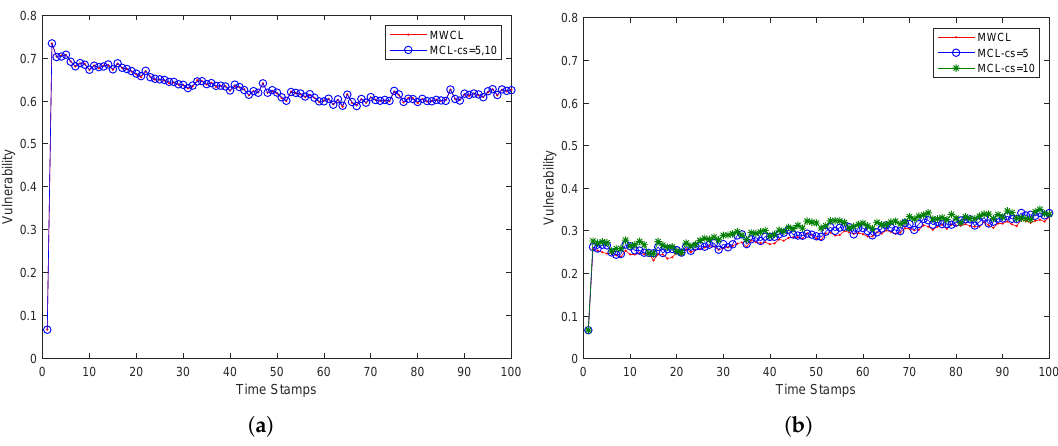
Figure 6. Both clustering and k -NN: ( a ) x and ( b ) ( x , y ) for N = 2000 trajectories and L = 100